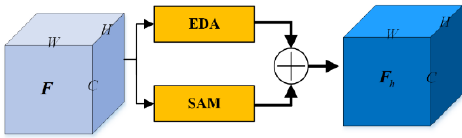
Figure 4. Pipeline of HAM.